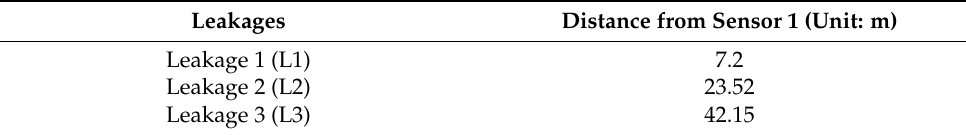
Table 2. Specific locations of the